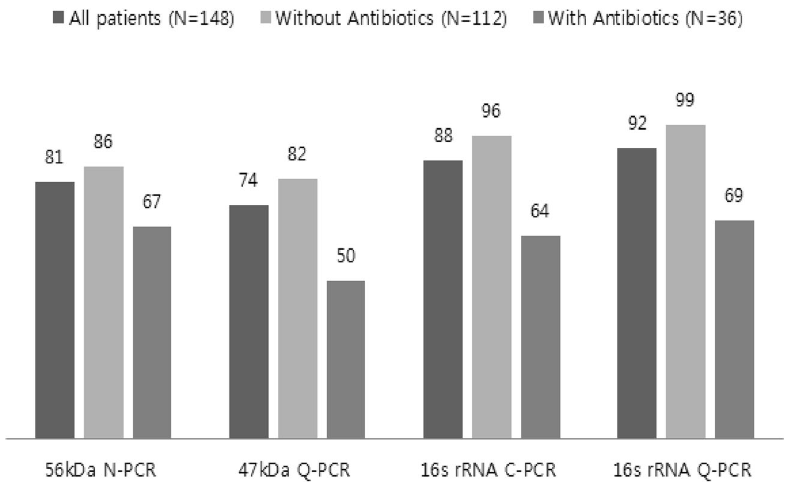
Figure 2. Sensitivities (%) of 56-kDa N-PCR, 47-kDa Q-PCR, 16S rRNA C-PCR, and 16S rRNA Q-PCR for three groups: all patients, patients without prior antibiotics treatment, and patients with prior antibiotics treatment.